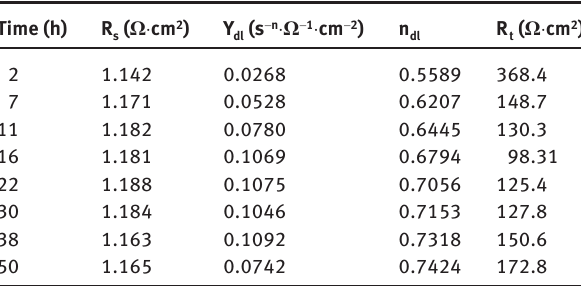
Fig. 7: Cross-sectional morphology of pure iron after immersion in molten (Li,Na,K)F at 973 K for 50 h.